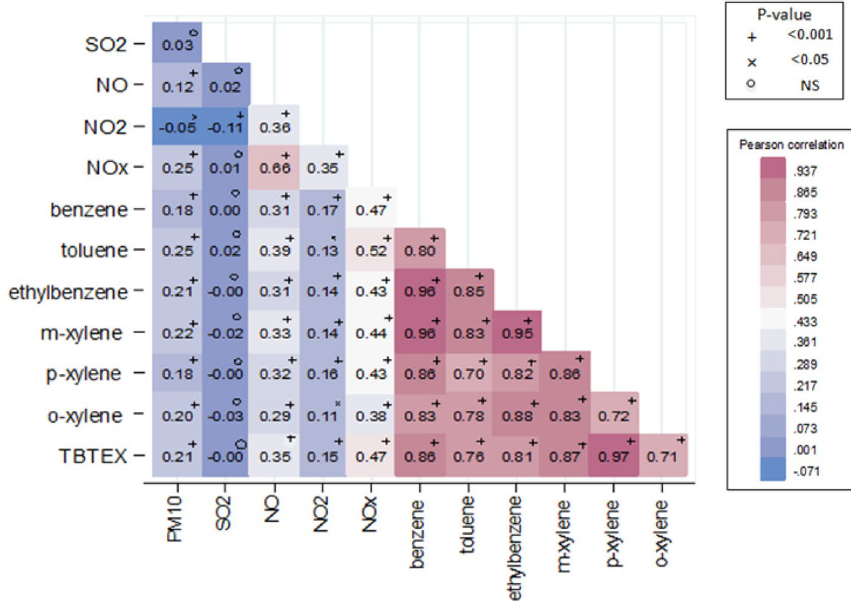
Figure 3. Pearson correlation matrix of air pollutants in the 22 districts of Tehran in 2014–2016.